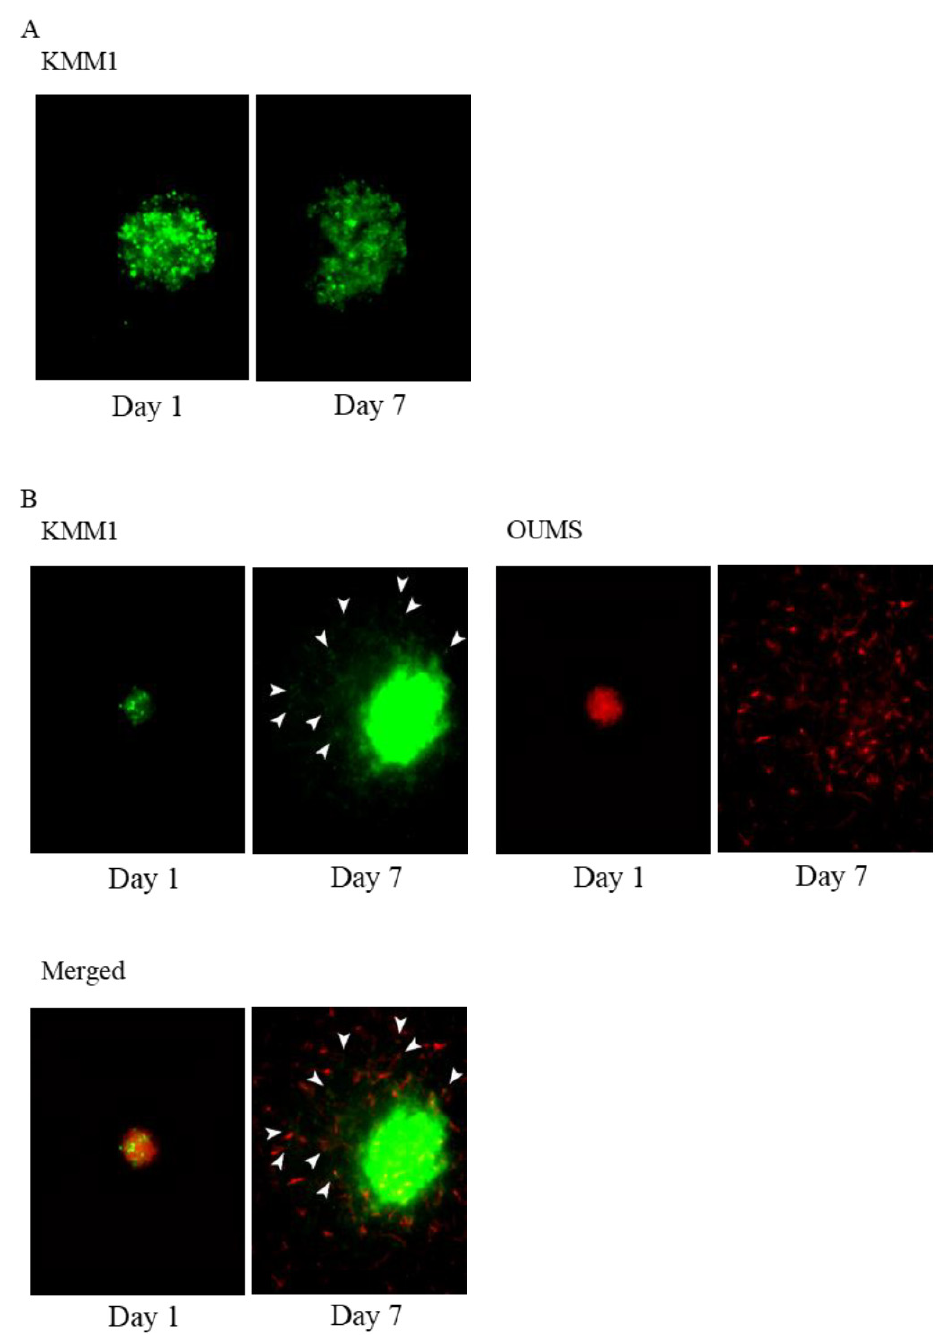
Figure 7. OUMS-36T-3F cells facilitate the invasion of MM cells. ( A ) Three-dimensional matrix invasion assays of KMM1 MM cells (green color stained with GFP) and ( B ) KMM1 MM cells (green color stained with GFP) with OUMS-36T-3F fibroblasts (red color stained with m-cherry). White arrows show KMM1 cells (green) migrating after OUMS-36T-3F cells (red).